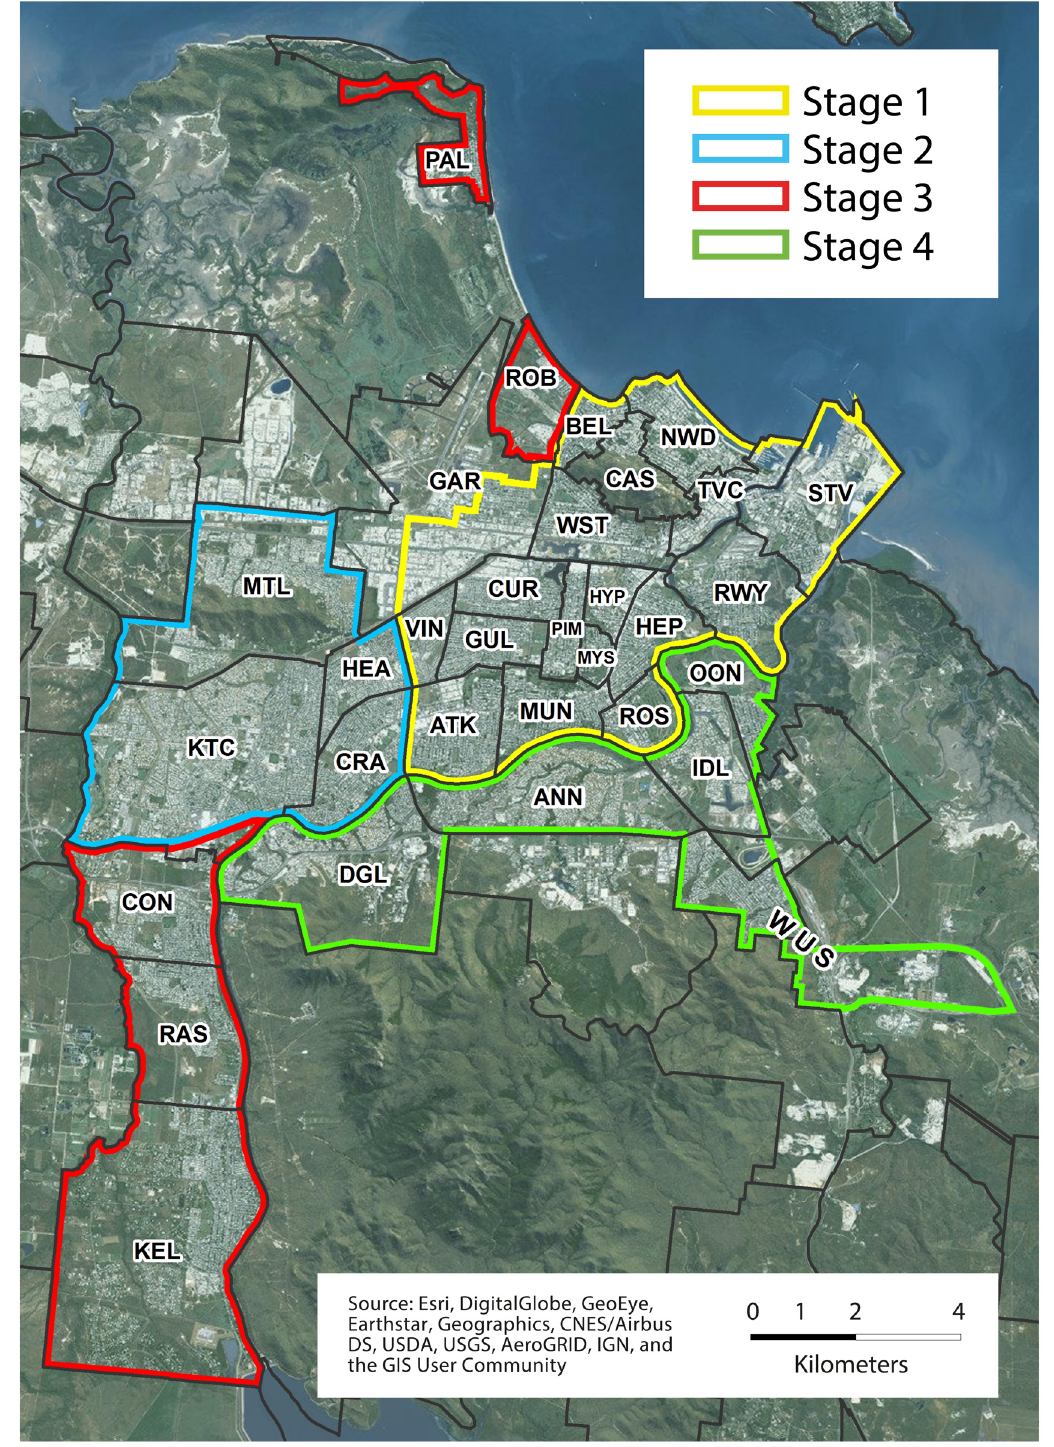
Figure 1. Release site. Map of Townsville city showing the boundaries of the four release